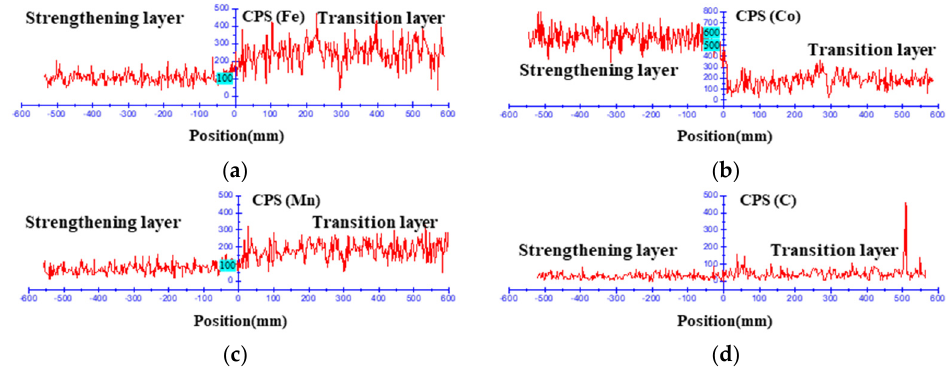
Figure 15. Microstructure of fusion zone between transition layer and strengthening layer.